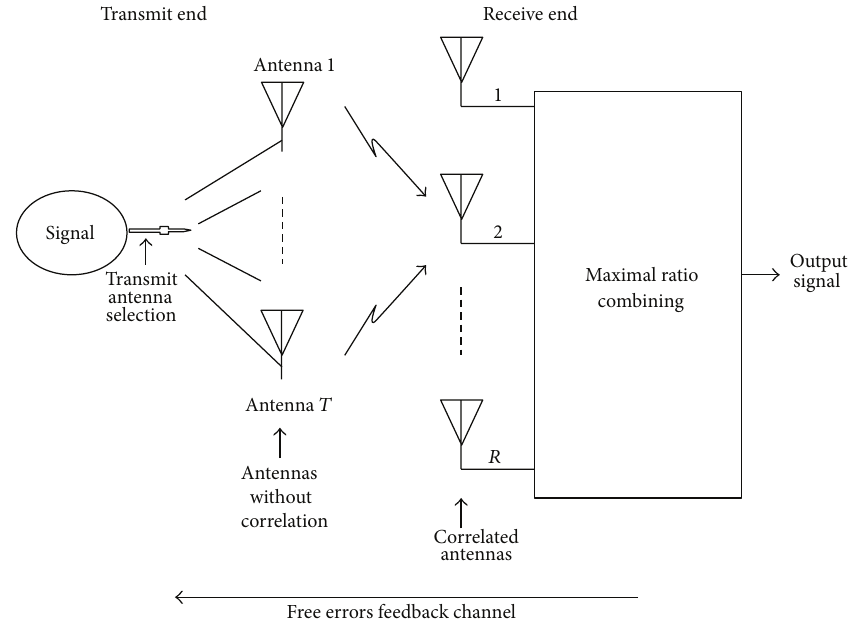
Figure 1: Simplified system